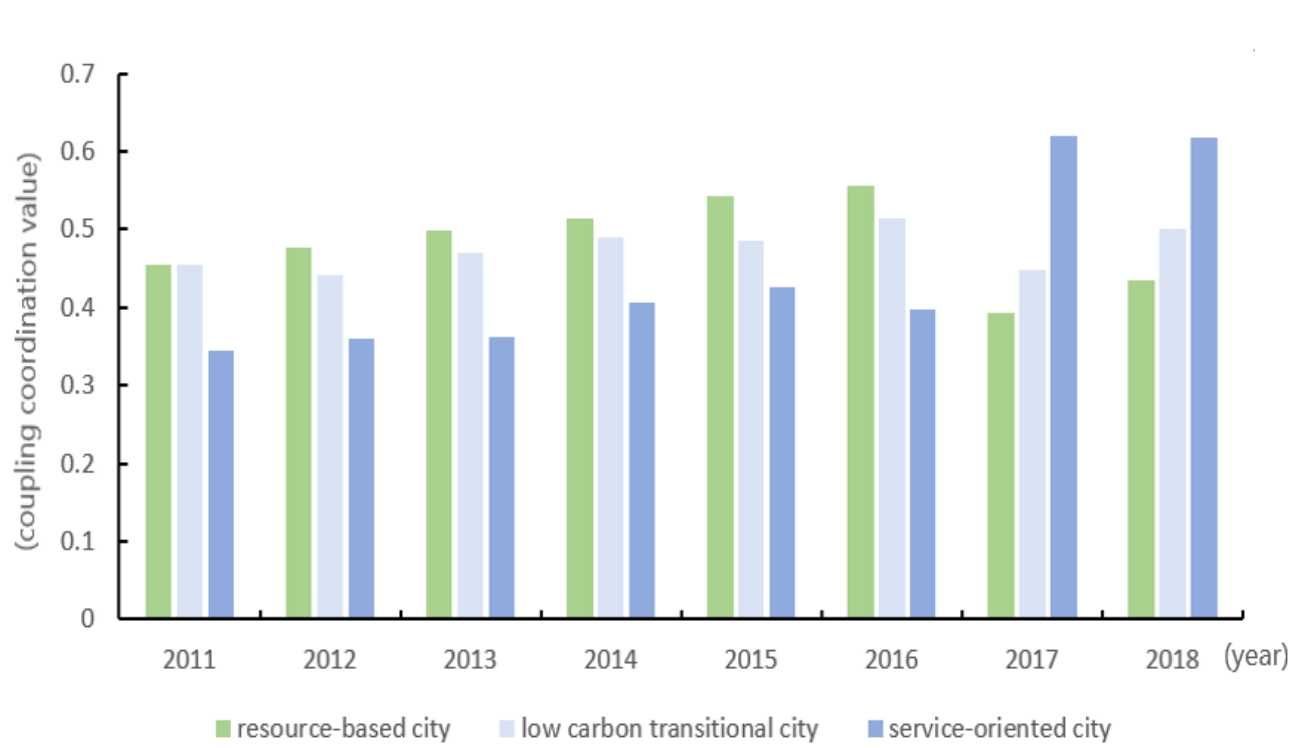
Figure 4. Status and trend of coupling and coordination of digital economy development and carbon emissions reduction in three types of